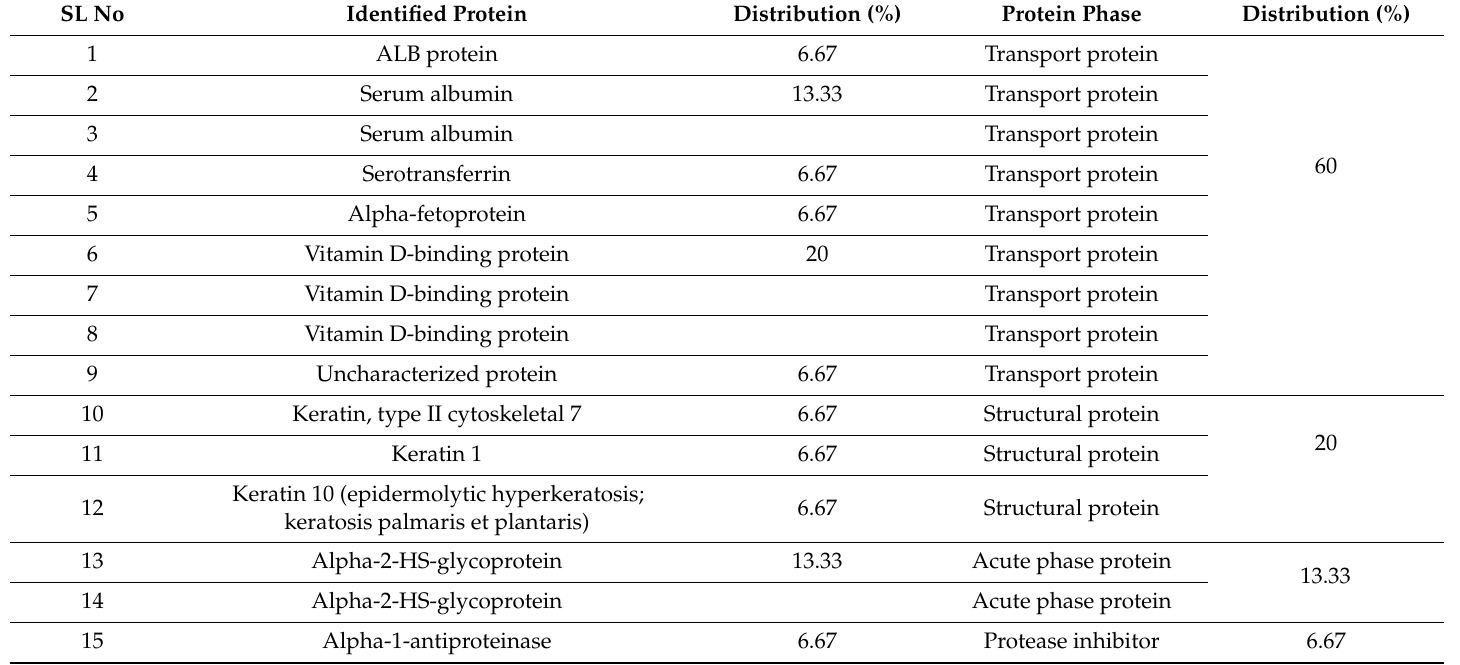
Table 8. Protein distribution (%) around CA NPs in 10%